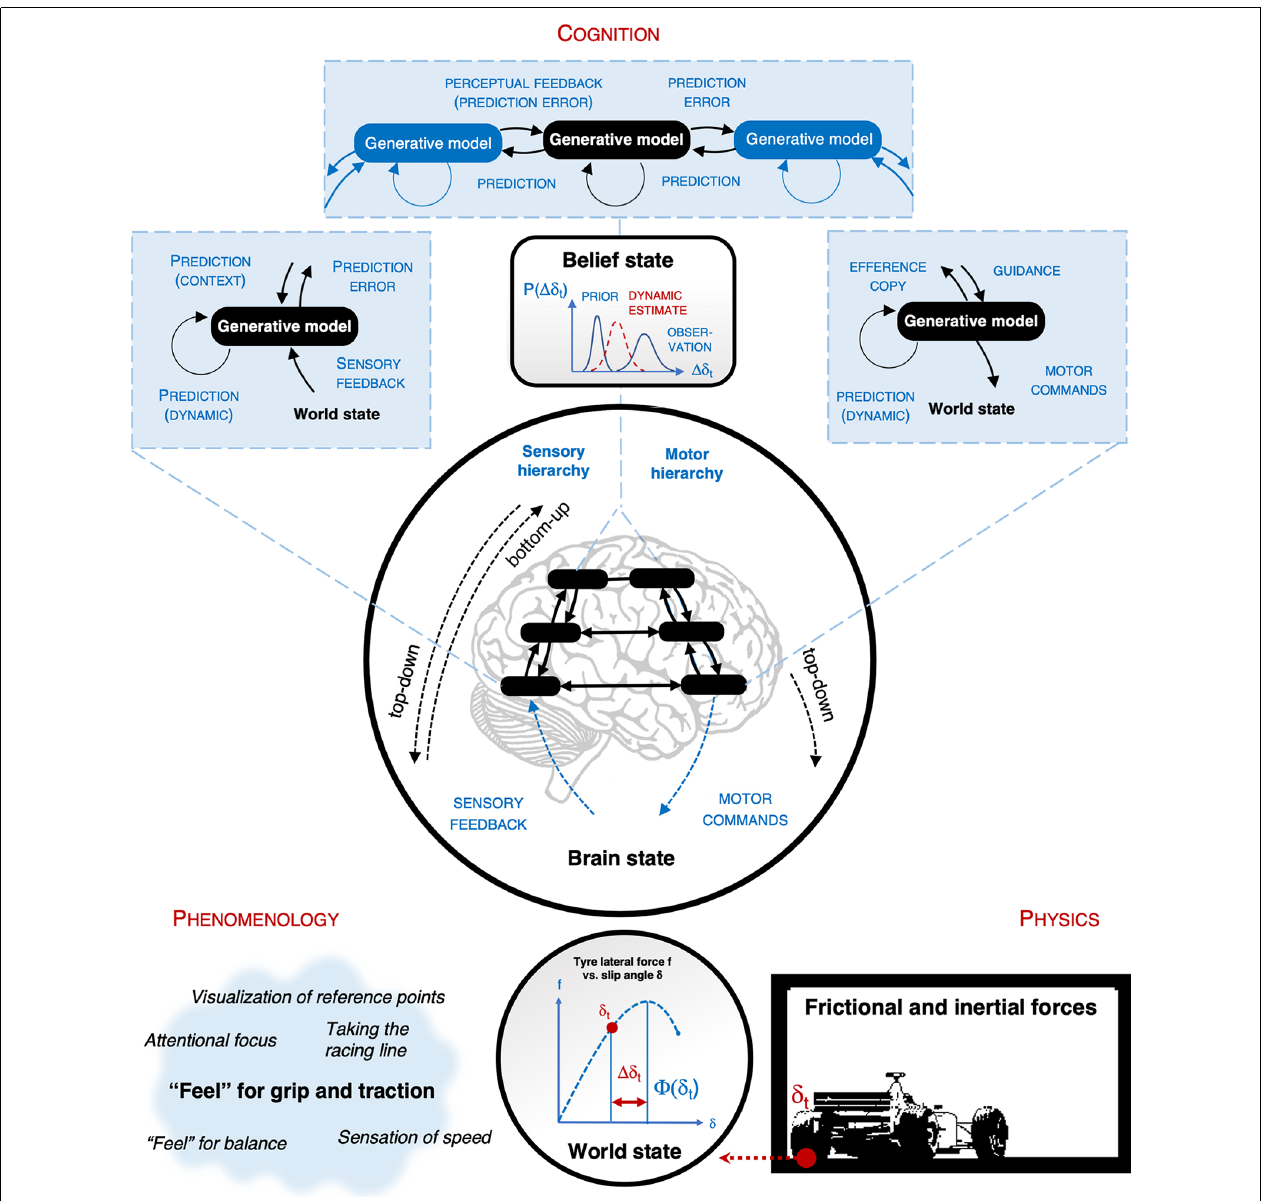
FIGURE 8 | Hierarchical predictive processing. The brain as an inference engine for estimating the state of the world (the estimate is sometimes called “belief state”). For example: a racing driver’s brain may estimate how far a tire slip angle is from the slip angle that produces maximal lateral force. Physically this will depend on the vertical load and rotation of the tire—but it does not follow that the brain’s relevant generative model must represent these component factors, to veridically “simulate” the actual physics (And for each level it is sufficient if they can provide the adjacent layer “predictive” information that elicits no prediction error, there is no “master belief state” where it all comes together). Prediction is hierarchical, with a sensory hierarchy (posterior parts of the brain) and motor hierarchy (anterior parts). Prediction is based on generative models always with the same basic architecture: each of them (i) stores information about some aspects of the world (only) and their dynamics as priors, (ii) receives feedback. Please note that the term “feedback” is used in different ways in different literatures. Here feedback flows in what is anatomically called the feedforward direction, and also in control theory the guidance signals would be called feedforward control. In the predictive brain framework feedback refers to the “new” information entering the system (at any level), which drives internal model update. For example in a Bayesian framework the feedback is observational data (and the dynamic predictor is the likelihood, the context and the memory internal to the generative model are priors), (iii) and possibly receives context information (predictions). On the basis of the internal model and context information, new feedback is predicted and compared to actual feedback; prediction error is used to update the internal model. Prediction error (only) is passed forward, as feedback to the next layer (predictive coding). Note that in a Predictive Processing architecture there is no architectural distinction between perceptual, motor, and cognitive representations. Both the sensory hierarchy and motor hierarchy embody the same architecture all the way down. Perceptual feedback is prediction error; so are guidance and motor commands (prediction of motor program activation, and proprioception/muscle activation, respectively; on the motor side the prediction error drives the motor system, which is called active inference). Note also that on the sensory side prediction error is “bottom up” but on the motor side, it is “top-down”, i.e., in the direction towards the sensorimotor periphery.